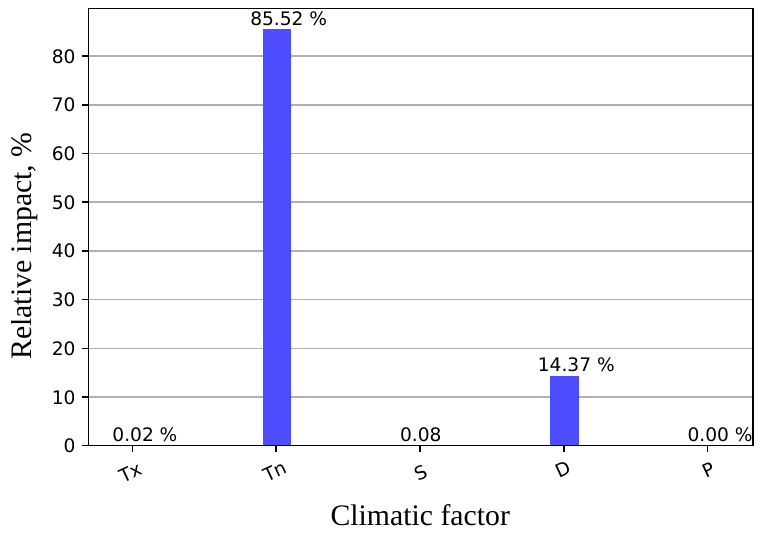
Figure 6. Impact of climatic factors.